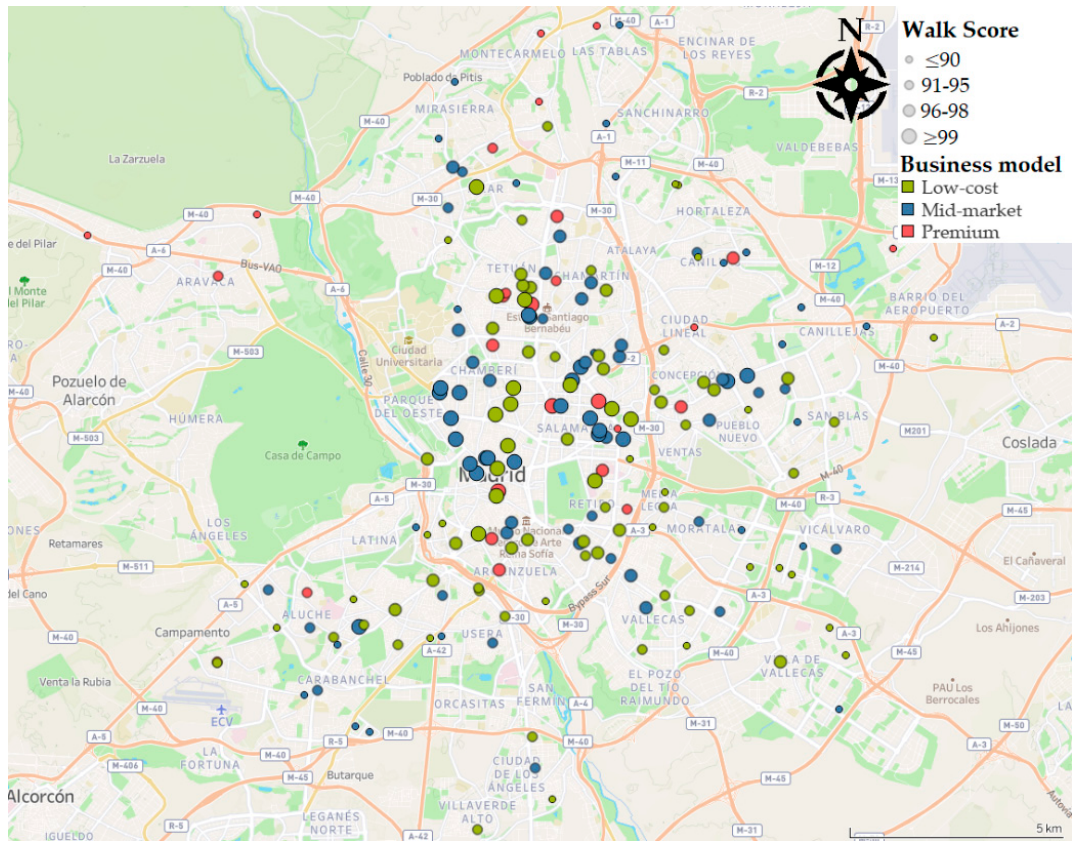
Figure 2. Distribution of the fitness centers in Madrid, sized by Walk Score ® .